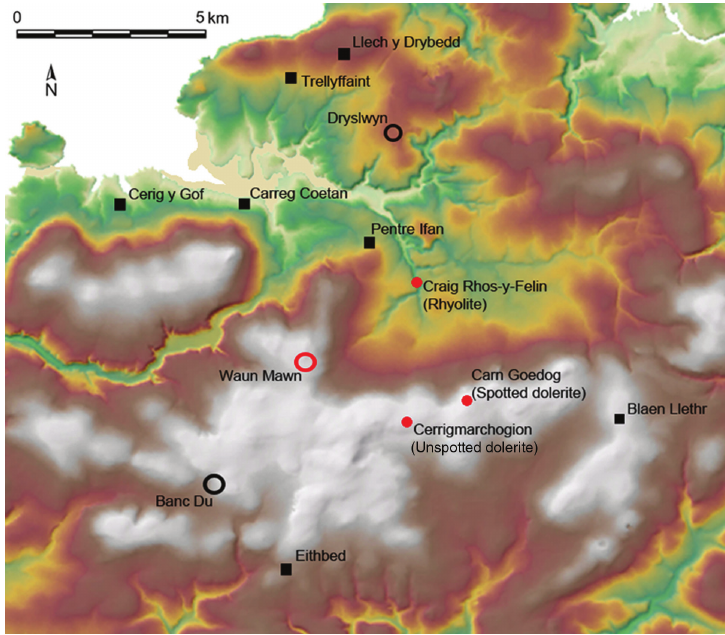
Figure 2 Location of the dismantled stone circle of Waun Mawn (red-ringed circle) as well as the bluestone sources of Carn Goedog (spotted dolerite), Craig Rhos-y-felin (rhyolite) and Cerrigmarchogion (unspotted dolerite). The locations of the Neolithic causewayed enclosure of Banc Du and palisaded enclosure of Dryslwyn (black-ringed circles), and Early Neolithic portal tombs (black squares) are also shown (Source: Mike Parker